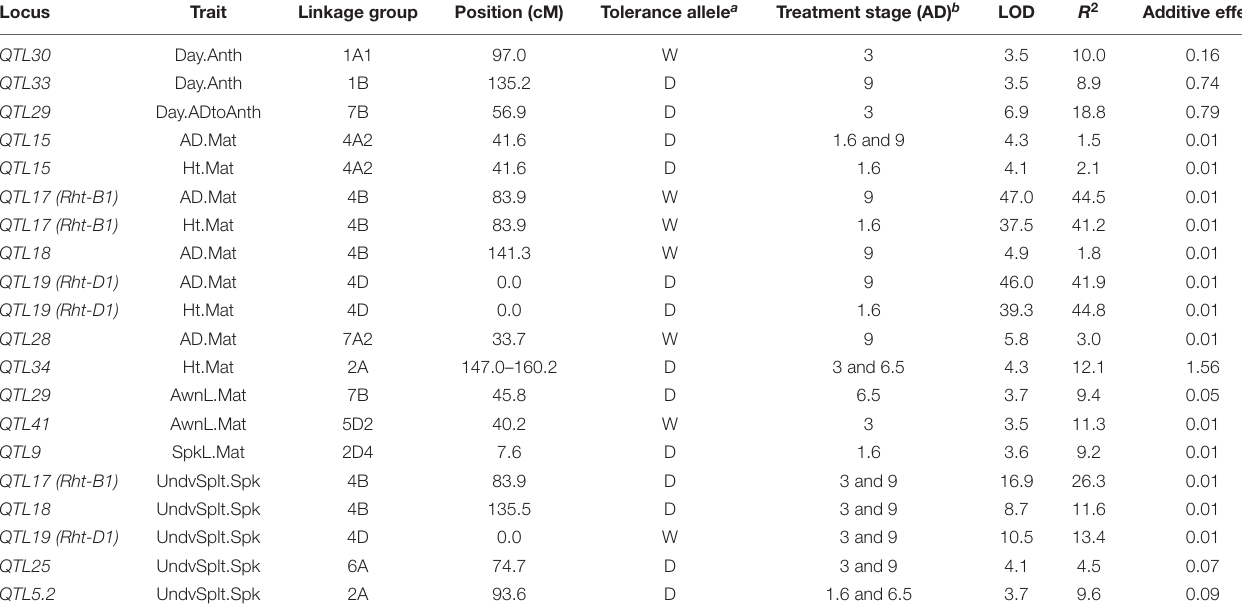
TABLE 3 | Heat-response QTL effects for traits other than floret fertility identified in the DH QTL experiment. Locus Trait Linkage group Position (cM) Tolerance allele a Treatment stage (AD) b LOD R 2 Additive effect